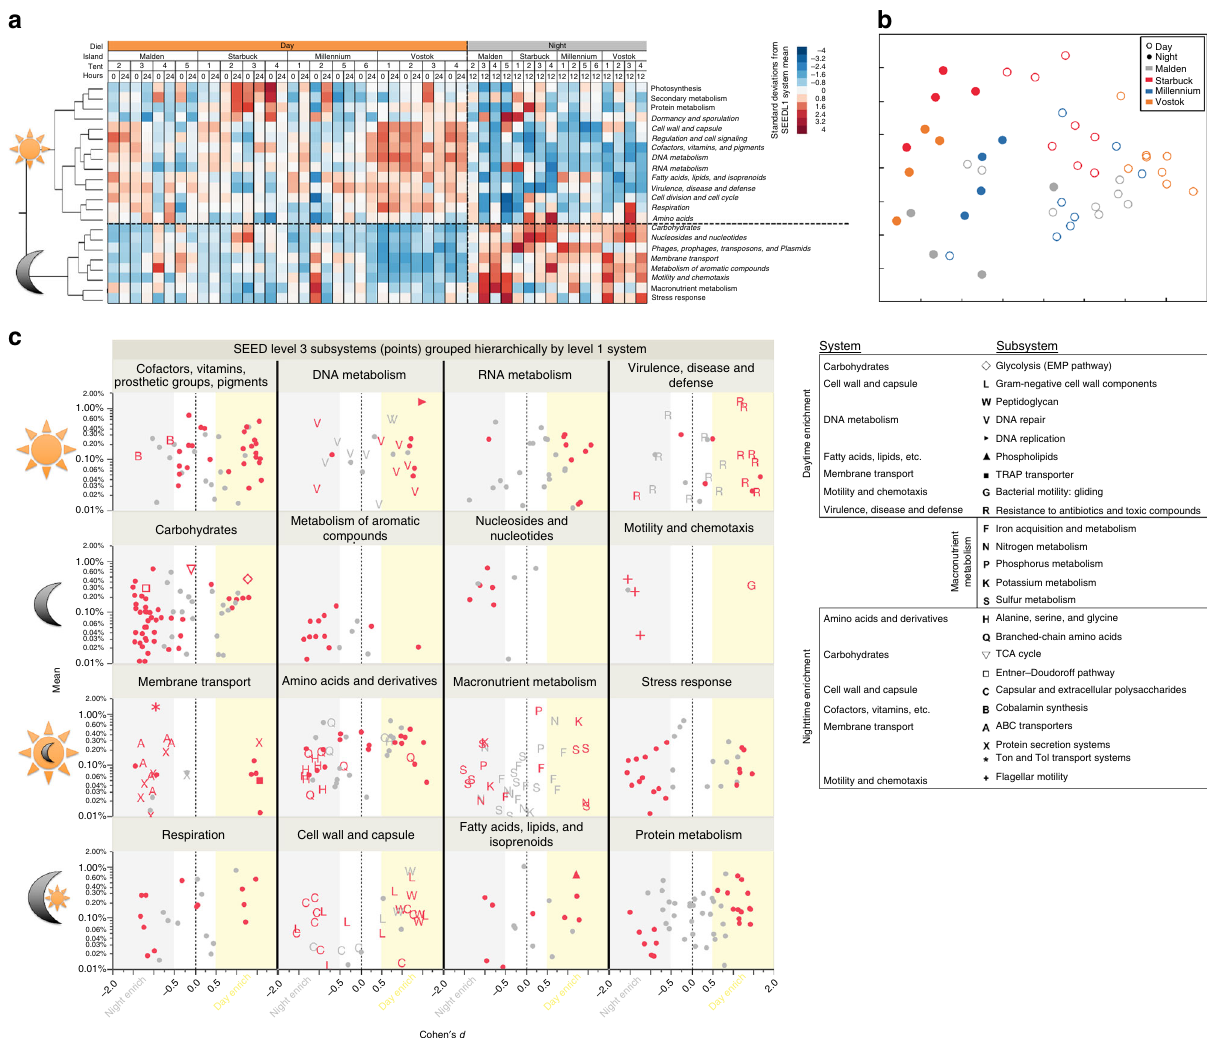
Fig. 3 Diel shifts in relative abundance of protein coding genes on coral reefs. Hierarchical clustering (Ward ’ s minimum variance method) of broad gene categories (heatmap of SEED Level 1 standard deviations) among samples collected during day and nighttime at each reef site on all four islands ( a ). Multidimensional scaling of sample Bray – Curtis distances calculated from SEED Level 1 relative abundances ( b ). Panel c shows relative abundance ( y ; mean percent of sequences per sample) and diel enrichment effect size ( x ; Cohen ’ s d , the difference in day and night mean divided by the standard deviation; | d | > 0.5 is considered moderately enriched) of protein-coding gene pathways (points, SEED Level 3 Subsystems) colored according to signi fi cant difference between day and night at each reef site (red are FDR corrected p < 0.05). Top row: cofactors, DNA metabolism, RNA metabolism, and virulence are all enriched during the day. Second row: carbohydrates, metabolism of aromatic compounds, nucleotides, and motility genes are all enriched at night. Third row: membrane transport, amino acids, macronutrient metabolisms, and stress response all tend toward nighttime enrichment; the latter two are not signi fi cant at Level 1. Bottom row: respiration, cell wall and capsule, fatty acids and protein metabolism show mixed enrichment of Level 3 pathways. This graphic represents over half of the main subsystems categories in the SEED database; the remaining Level 1 subsystem categories did not contain abundant shown in a did have at least one Level 3 subsystem signi fi cantly different between day and night. Source data are provided as a Source Data File the family Rhodobacteraceae (Alphaproteobacteria) that on average represented 17% of the night population and up to 33% on Starbuck. Gammaproteobacteria from the Genus Halomonas (Oceanospirillales) and Alteromonas also represented a signi fi cant proportion of the night community (up to 40% at sites on Star- buck and Malden and >50% at sites on Vostok and Malden, respectively). The difference in diel patterns between open ocean communities and those associated with coral reef habitats re fl ects the potential for a benthic – pelagic coupling of the microbial food web.